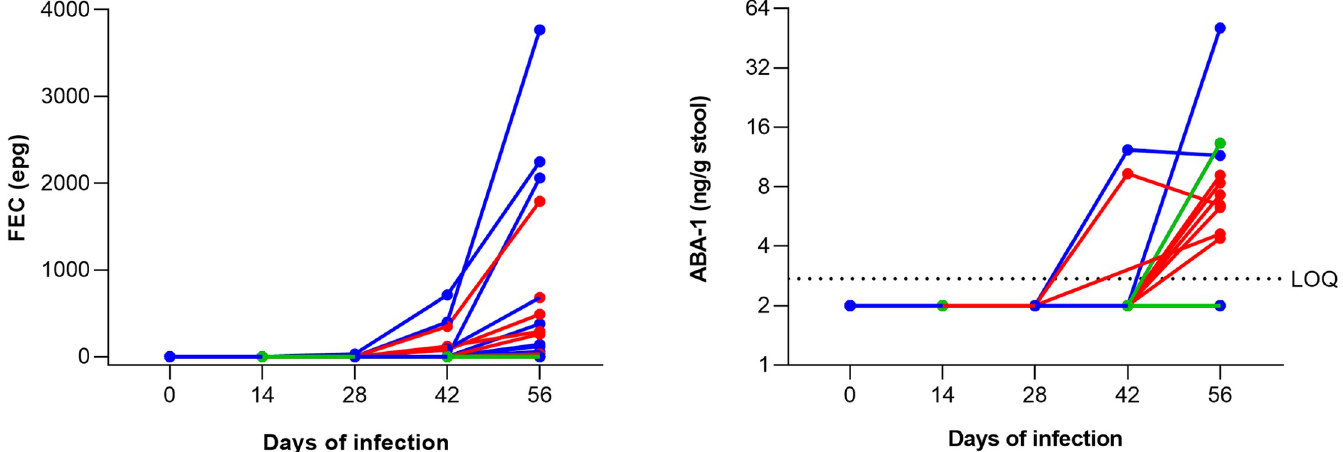
Fig 3. Quantification of fecal egg count ( A ) and ABA-1 in stool ( B ) from A . suum infected pigs: control group (green), low (red) and high (blue) trickle infected pigs. Stool samples were collected before infection (Day 0) and at different timepoints during trickle infection: 14 days, 28 days, 42 days and 56 days.